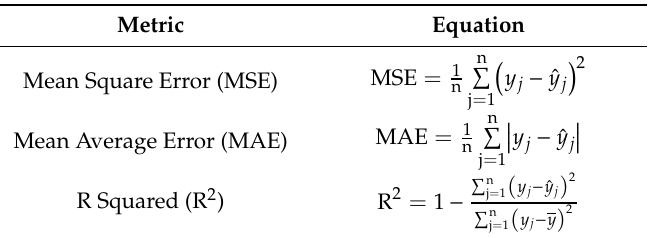
Table 5. Regression